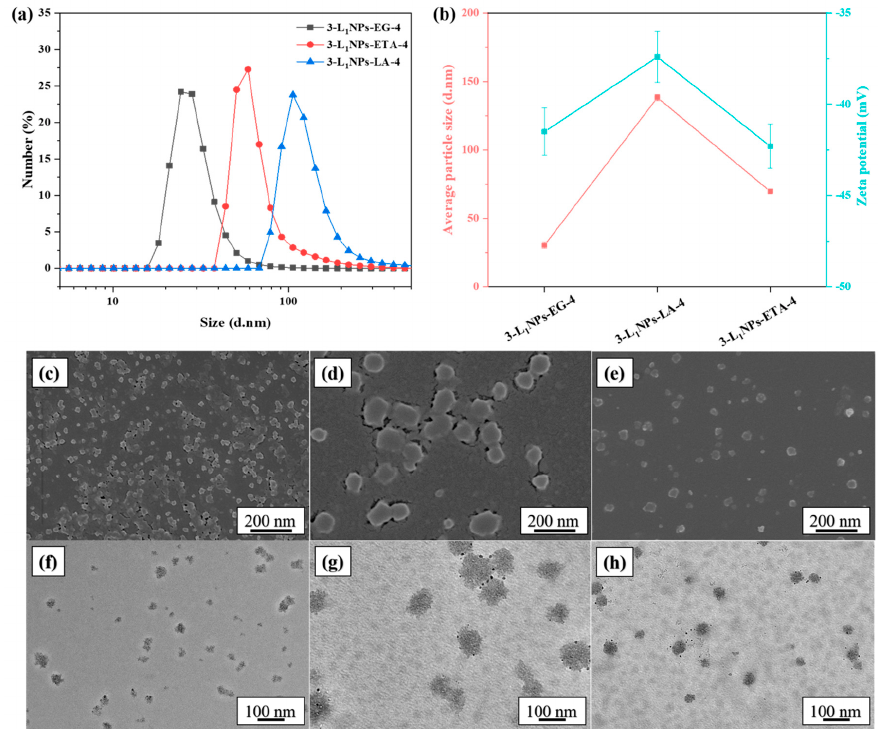
Molecules 2021 , 26 , x FOR PEER REVIEW 5 of 13 Figure 2. ( a ) Particle size distribution, ( b ) average size and zeta-potential, ( c – e ) SEM and ( f – h ) TEM images of LNPs obtained with different types of DES. ( c , f ) 3-L 1 NPs-EG-4, ( d , g ) 3-L 1 NPs-LA-4, ( e , h ) 3-L 1 NPs-ETA-4.